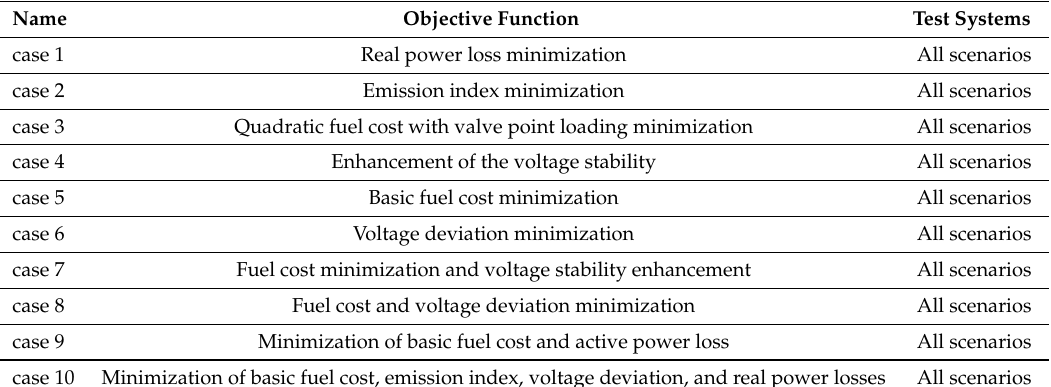
Figure 2. Scenario 1: IEEE 30-bus system. Table 4. Summary of case